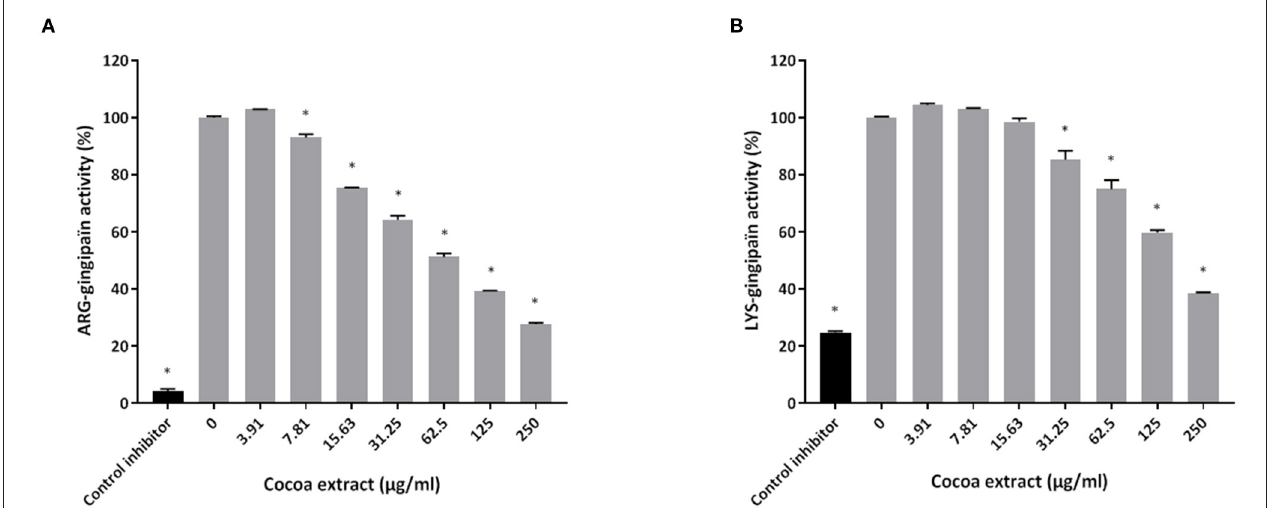
FIGURE 4 | Effect of the cocoa extract on the Arg-gingipain activity (A) and Lys-gingipain activity (B) of P. gingivalis . Tosyl-L-lysine chloromethyl ketone hydrochloride was used as a control inhibitor. Hydrolysis of the chromogenic substrates was monitored by recording the absorbance at 405nm (A 405 ) after 60min (Arg-gingipain) or